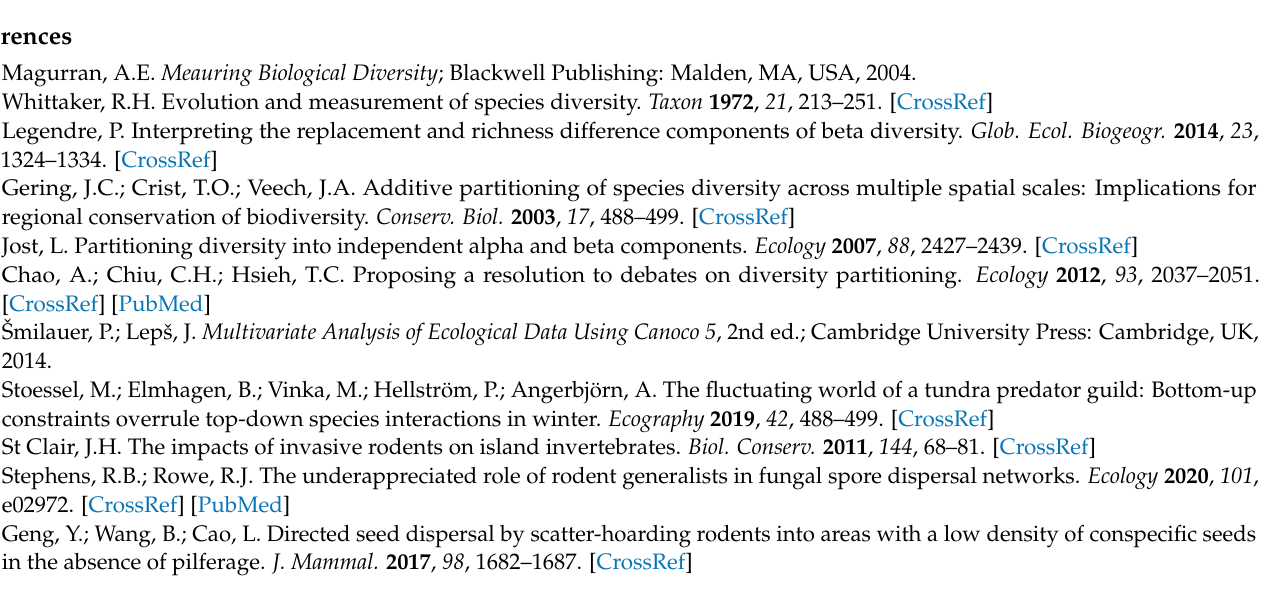
Figure A2. Partitioning of heterogeneity (expressed as Simpson index) ( a ) of the surveyed forest types (gamma diversities) into local diversity at the level of forest plots (alpha), species turnover among plots of the same forest type (spatial beta) and species turnover among survey years of the same forest type (temporal beta) ( b ) of Romanian forests (epsilon diversity) into local diversity at the level of forest plots (alpha), species turnover among plots of the same forest type (spatial beta), species turnover among survey years of the same forest type (temporal beta), and the diversity at the level of forest types (delta).